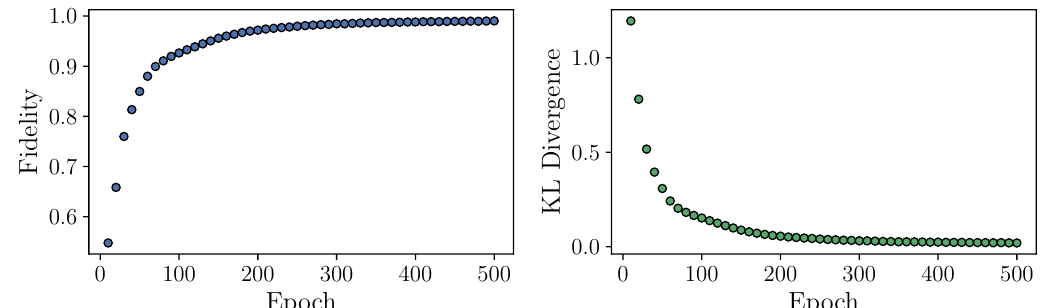
Figure 1: The fidelity (left) and the KL divergence (right) during training for the reconstruction of the ground state of the one-dimensional